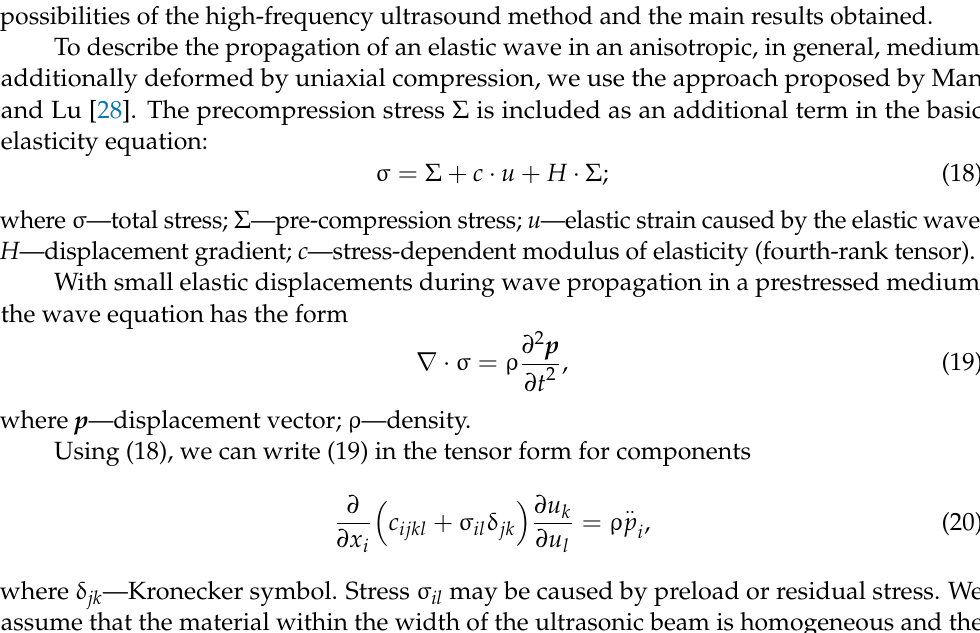
Figure 1. Relative change in the reverse flexibilities moduli c E (3) and c D (4) for the apolar piezoceramic BaTiO 3 depending on the relative volume of the 11 11 reoriented domains under the compressive stress along the “ X ” axis. Relative change in the elastic moduli c E (5) and c D (6) under the same 11 11